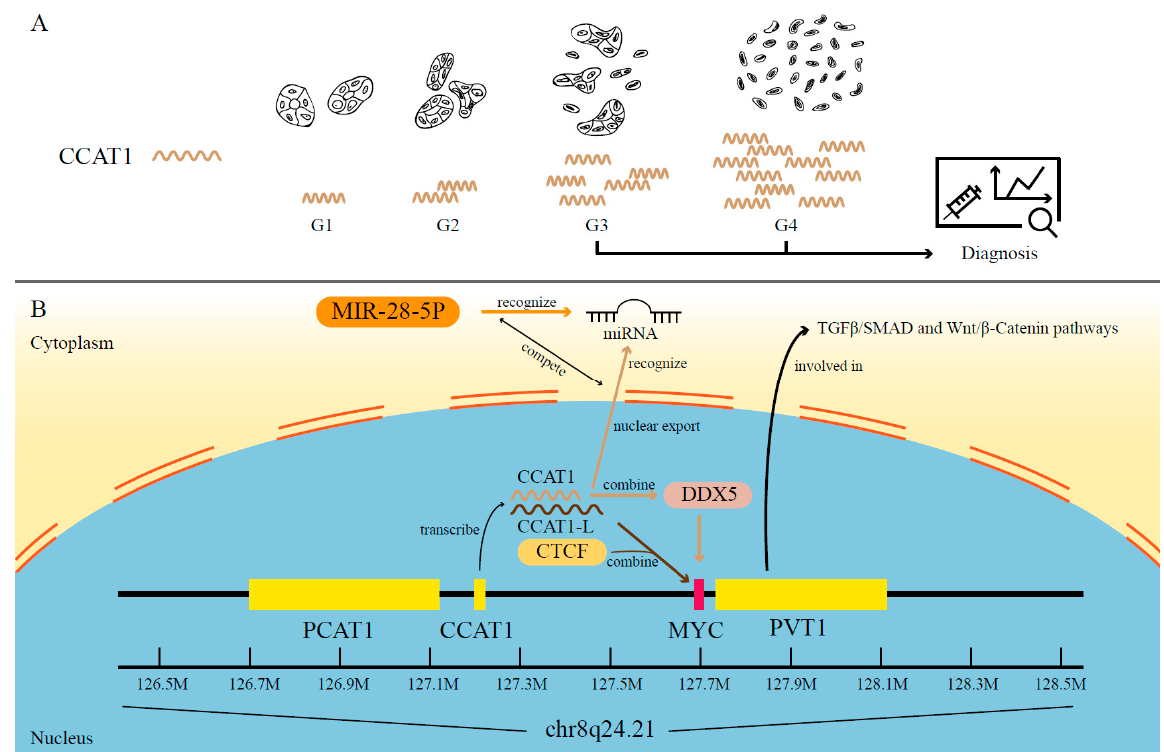
Figure 1. The mechanisms of eRNAs transcribed from chr8q24.21. ( A ) Utilizing CCAT1 as a diagnostic biomarker to distinguish CRC stages (III and IV). ( B ) The different mechanisms of CCAT1 and CCAT1L in the nucleus and the cytoplasm, as well as the impact on eRNA and follow-up pathways by a variant inside the PVT1 region.